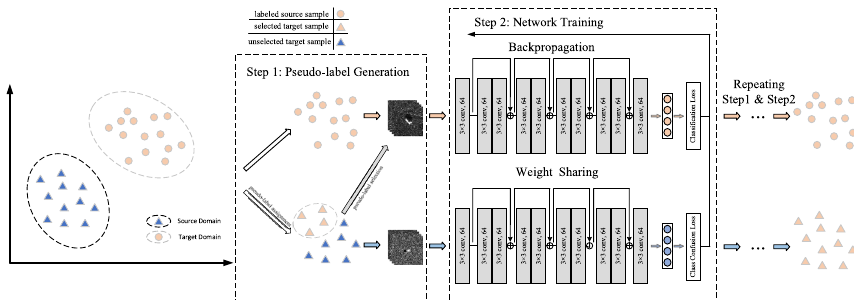
Fig. 3 The diagram of SPL-CCR for SAR target classification